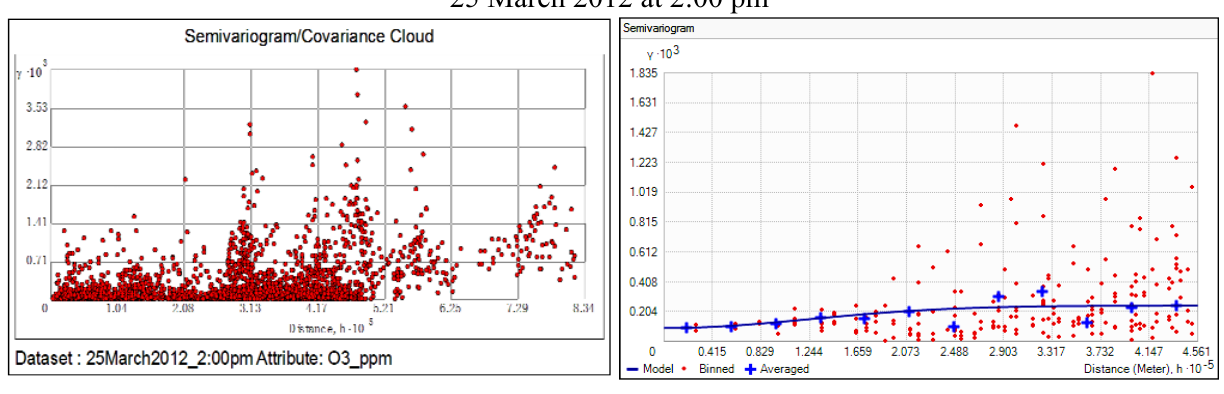
Figure 5. Spatial autocorrelation in O